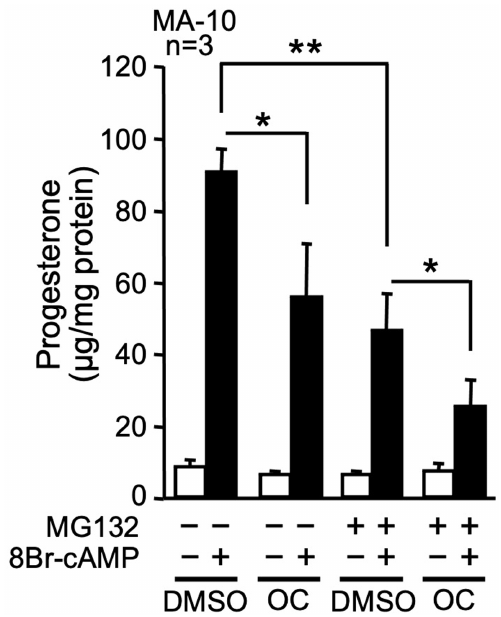
Figure 2. The OC mixture affects steroidogenesis, even when protein degradation is inhibited. MA-10 Leydig cells were treated with either DMSO or 10 µg/mL of OC mixture for 2 h and then treated for another 4 h with (+) or without ( − ) 0.1 mM 8Br-cAMP and 10 µM MG132 (an inhibitor of protein degradation) as indicated. Progesterone production was quantified by ELISA and corrected according to protein concentration. Values are the mean of three individual experiments, each performed in duplicate ( ± SEM). *: p < 0.05, **: p < 0.01.